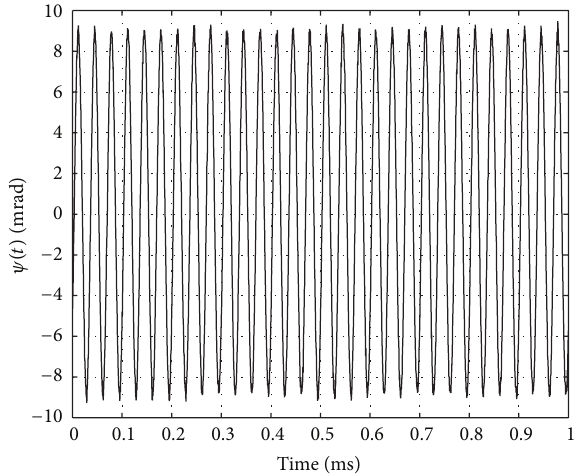
Figure 12: FM demodulation of a signal with 𝑓 𝑚 = 30 kHz and Δ𝑓 = 100